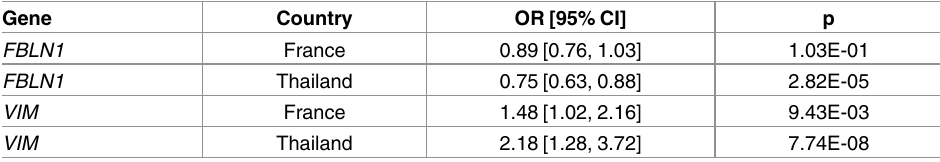
Table 1. Odds ratios (OR) of hepatocellular carcinoma and 95% confidence intervals (CI) for a per- centage point increment in methylation. Gene